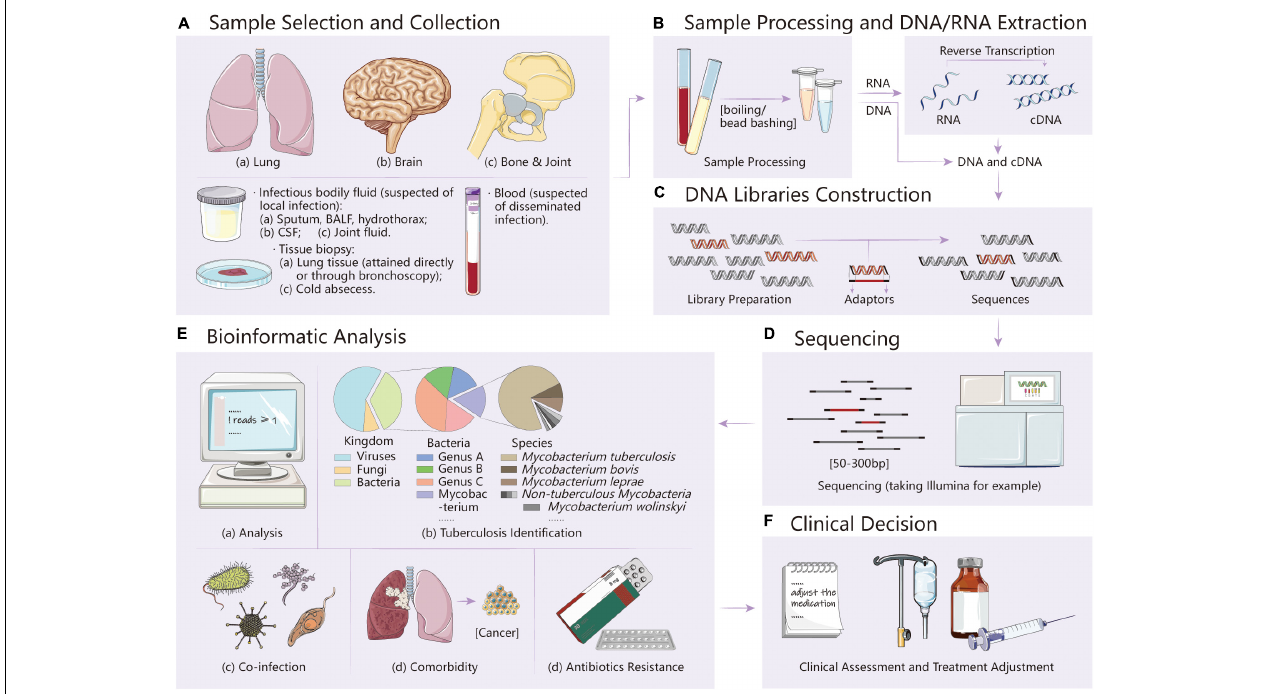
FIGURE 1 | (A) Sample selection and collection. Infectious fluids and tissues can be taken under the evaluation of clinicians. (B–D) Experimental procedures (wet lab) of mNGS, mainly including sample processing and DNA/RNA extraction, DNA libraries construction, and sequencing. (E) Bioinformatic analysis (dry lab) of mNGS. With the analysis pipeline modification, it is promising to determine tuberculosis, co-infection, comorbidity, and antibiotics resistance simultaneously. (F) Clinical decision. After obtaining the report, clinical assessment and treatment adjustment can be made